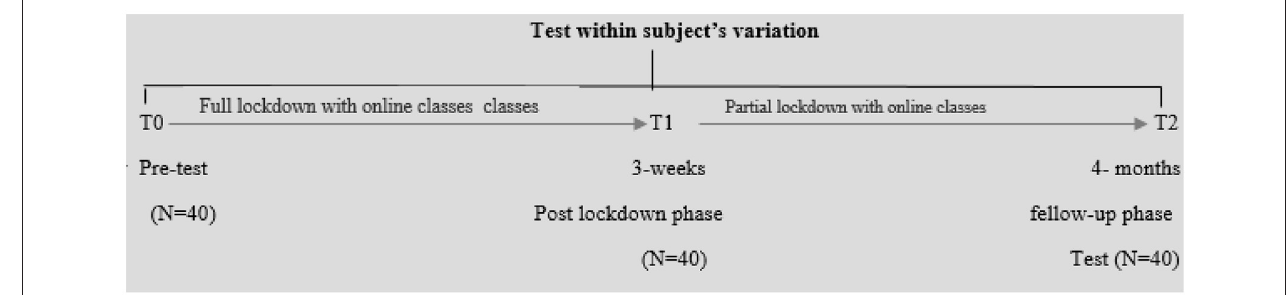
FIGURE 1 | Within group, pretest–posttest design, quasi-experimental research for both full and partial lockdown